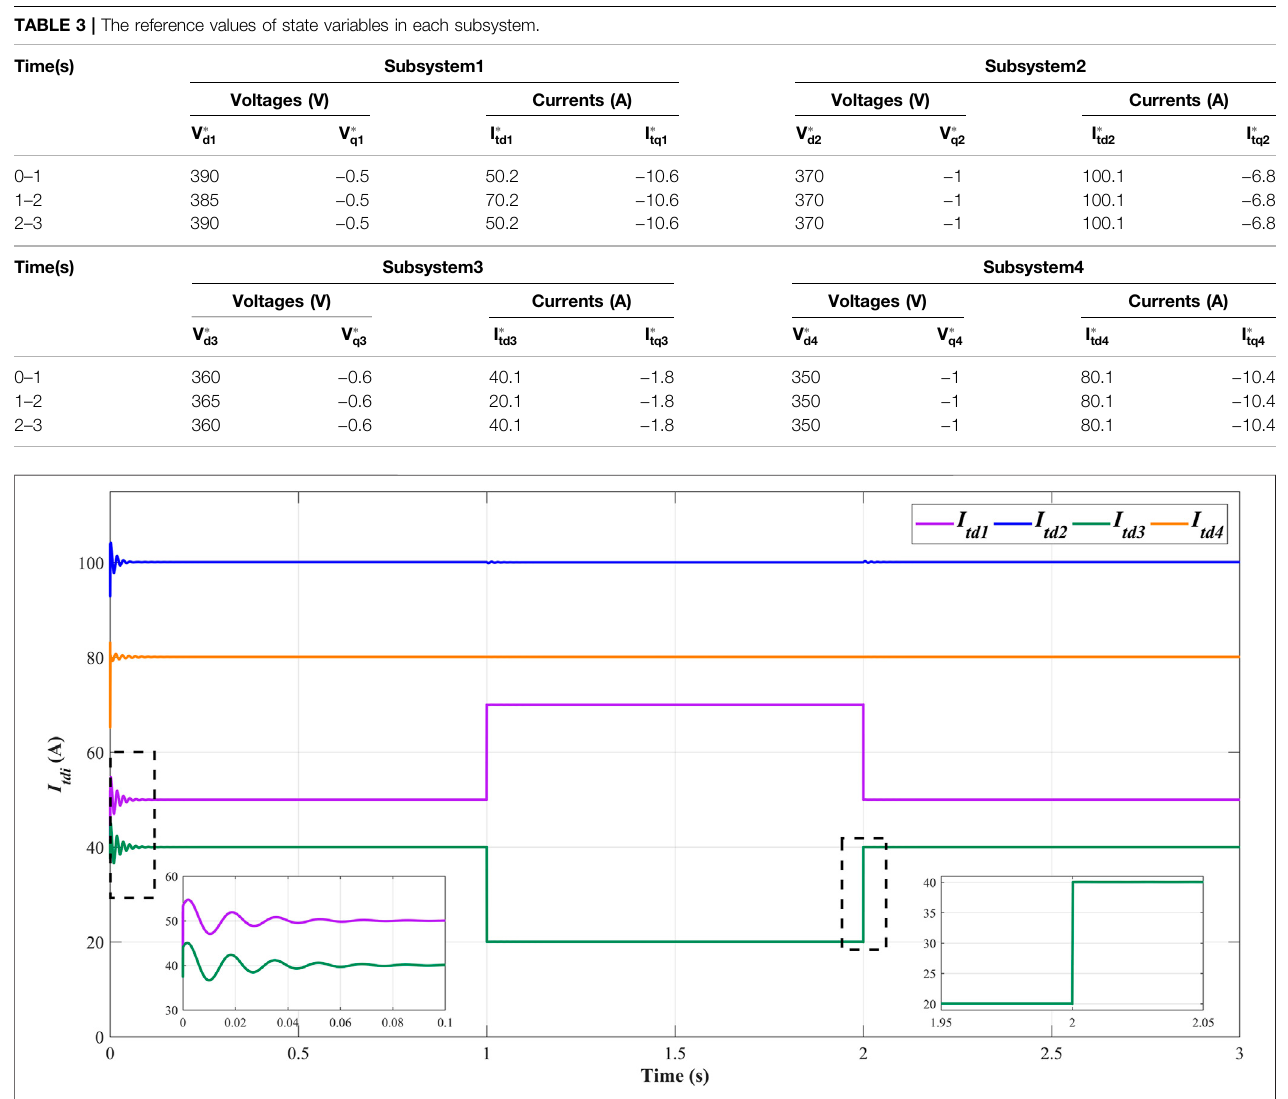
Frontiers in Energy Research |